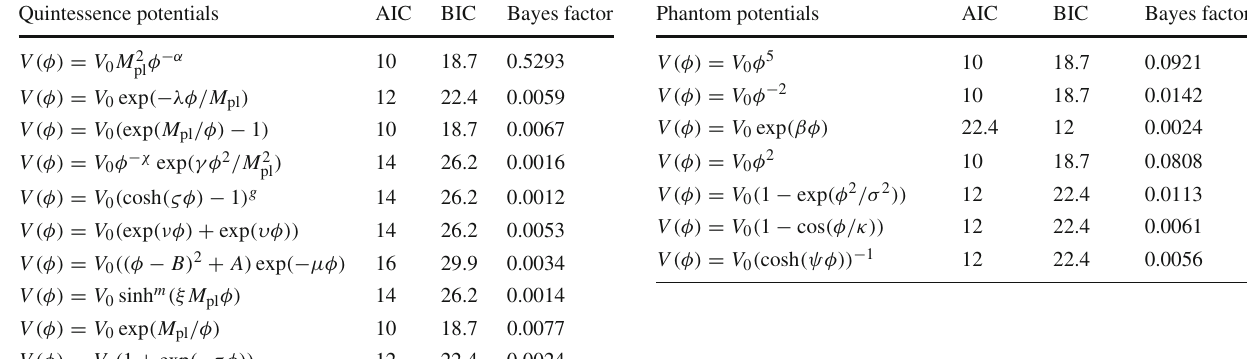
Table 3 The list of the dark energy quintessence potentials, with cor- responding AIC , BIC , and Bayes factors Quintessence potentials AIC